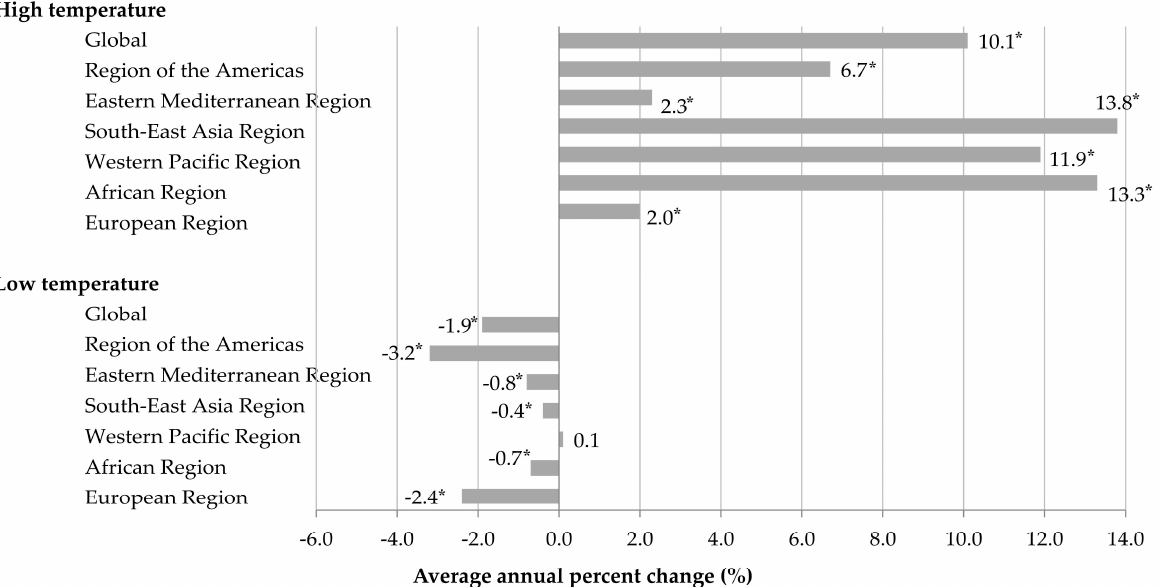
Figure 3. Global ischemic heart disease mortality rates (per 100,000) attributed to low temperature, by sex, 1990–2019; a joinpoint regression analysis.